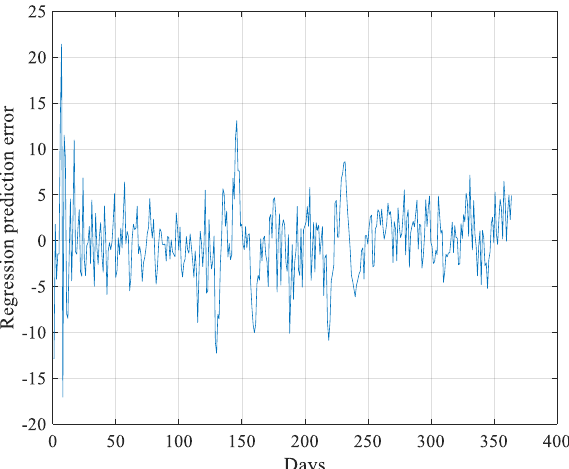
Figure 13. Error chart of reconstructed signal regression prediction .